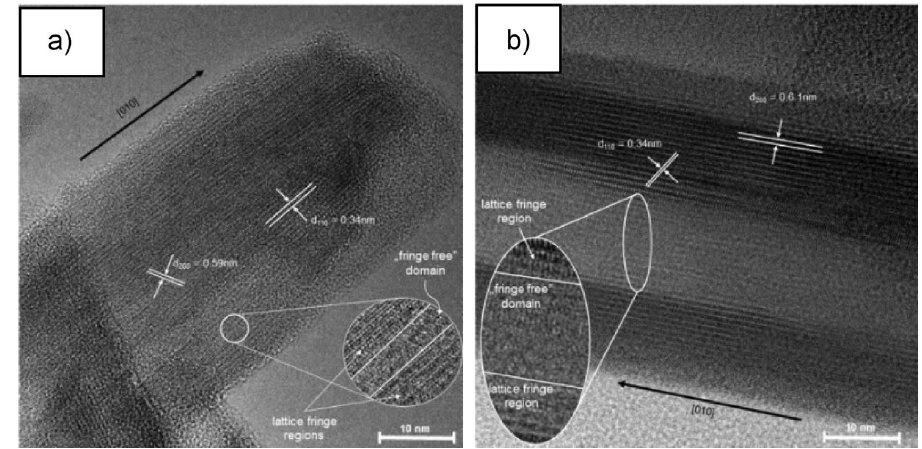
Figure 2. High-resolution TEM image of KVO-20 ( a ) and KVO-40 ( b